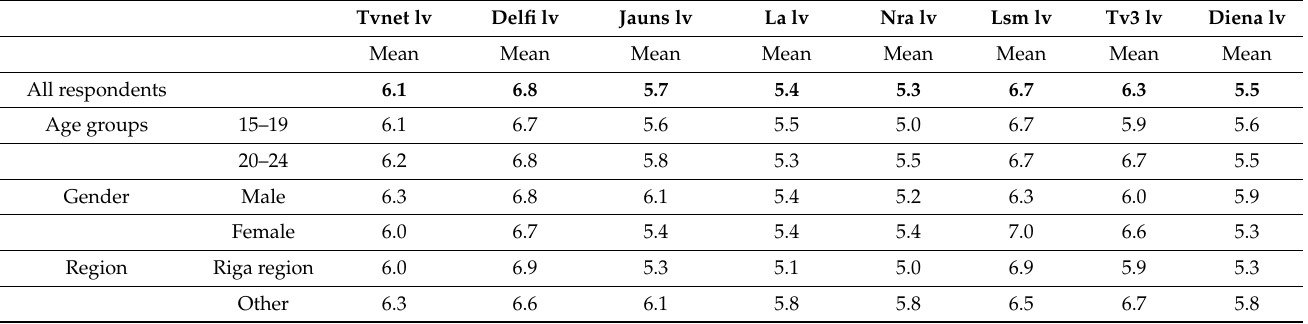
Table 11. News media uniqueness, as evaluated by a 15- to 24-year-old audience in Latvia, 2022. Tvnet